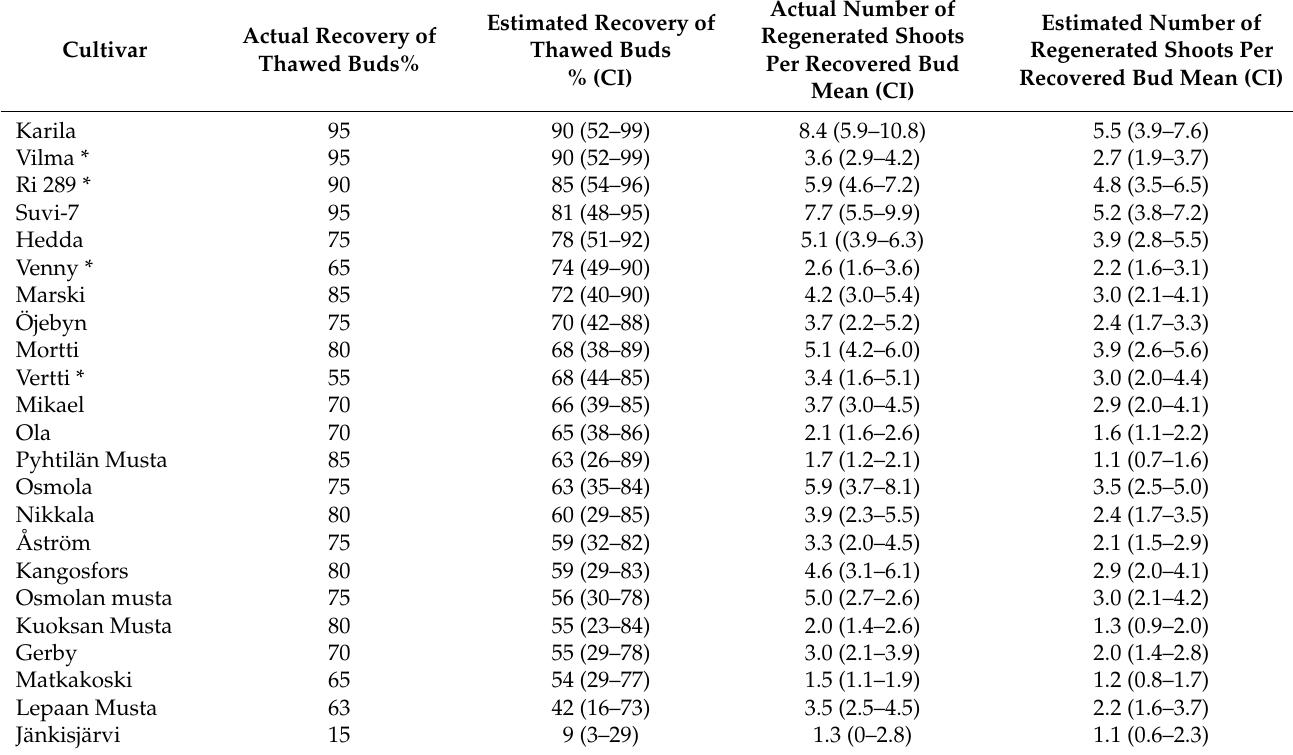
Table 2. The measured and estimated recovery of buds and measured and estimated number of regenerated shoots per bud of 23 blackcurrant cultivars. The recovery of buds was evaluated after ten weeks of in vitro culture. Results are based on 20 or 21 thawed buds per cultivar, but contaminated initiations were rejected from evaluations. The estimated values take into count the effect of bud type (vegetative or floral) and the size of the bud. CI, 95% confidence